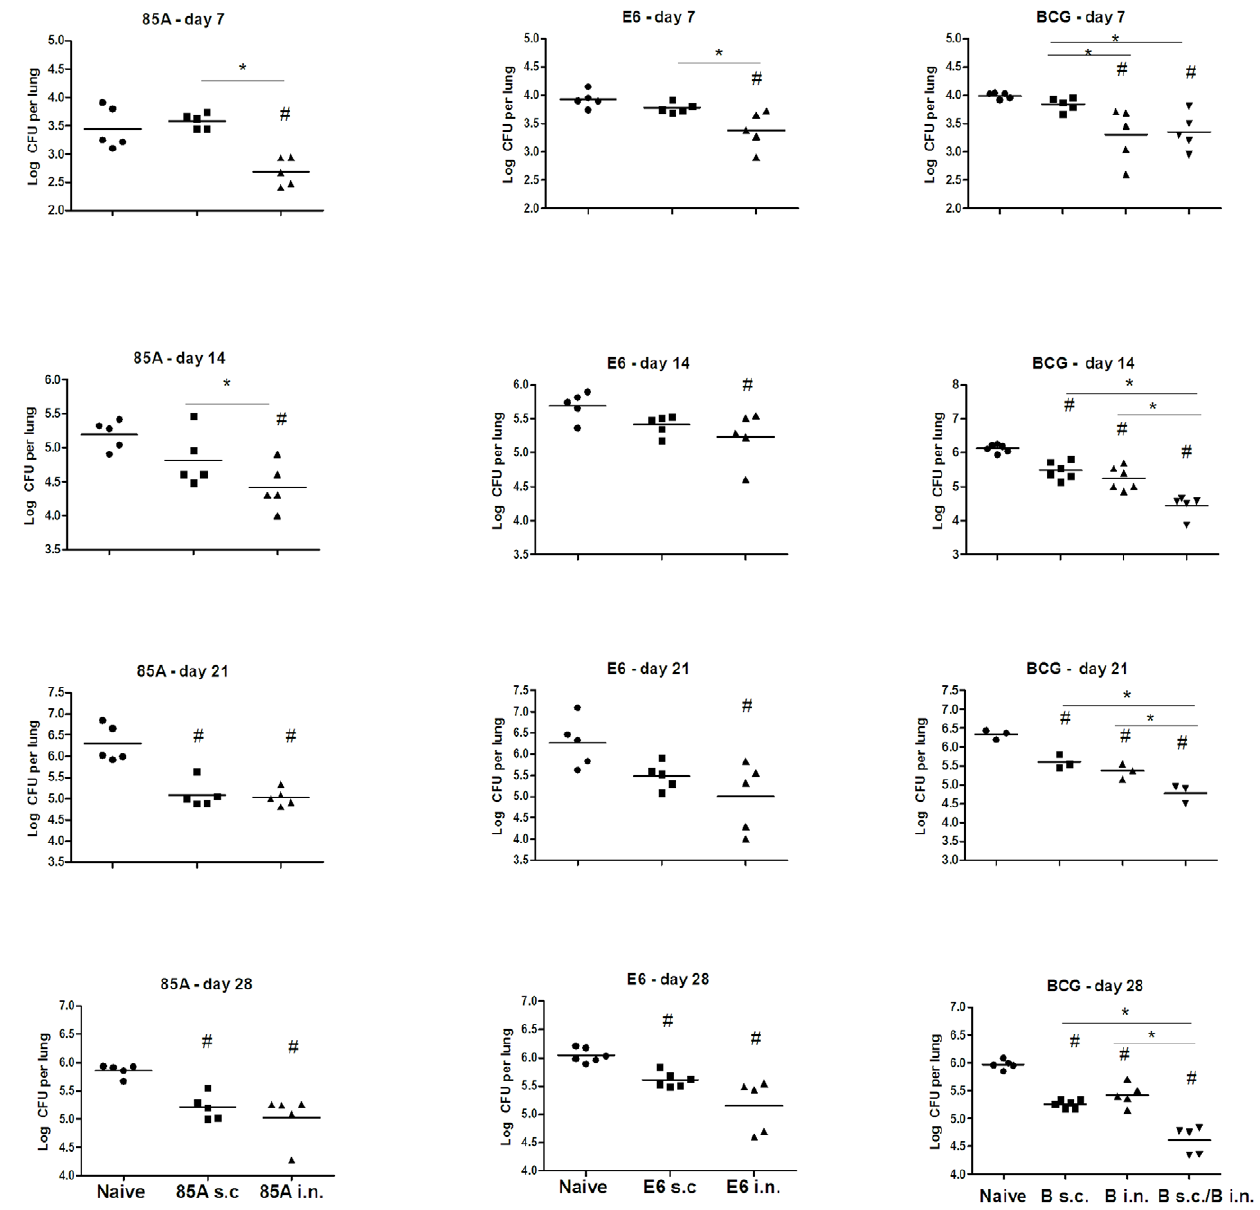
Figure 6. Mtb growth in individual mice after s.c. and i.n. immunization. The figure shows results for individual mice from the experiments shown in Fig. 5. C57BL/6 mice were immunized once with BCG s.c., BCG i.n. or BCG s.c./BCG i.n. or 3 times at two weekly intervals with 85A s.c., 85A i.n., E6 s.c. or E6 i.n. Ten weeks after immunization with BCG or 4 weeks after the last immunization with 85A or E6 mice were challenged with Mtb and groups of 3–5 mice sacrificed 7, 14, 21 and 28 days later for enumeration of lung Mtb cfu. Representative data from one of two experiments are shown. Horizontal lines show group means. # indicates a significant difference from naı¨ve mice and * a significant difference between indicated groups. One-way ANOVA with Tukey’s post